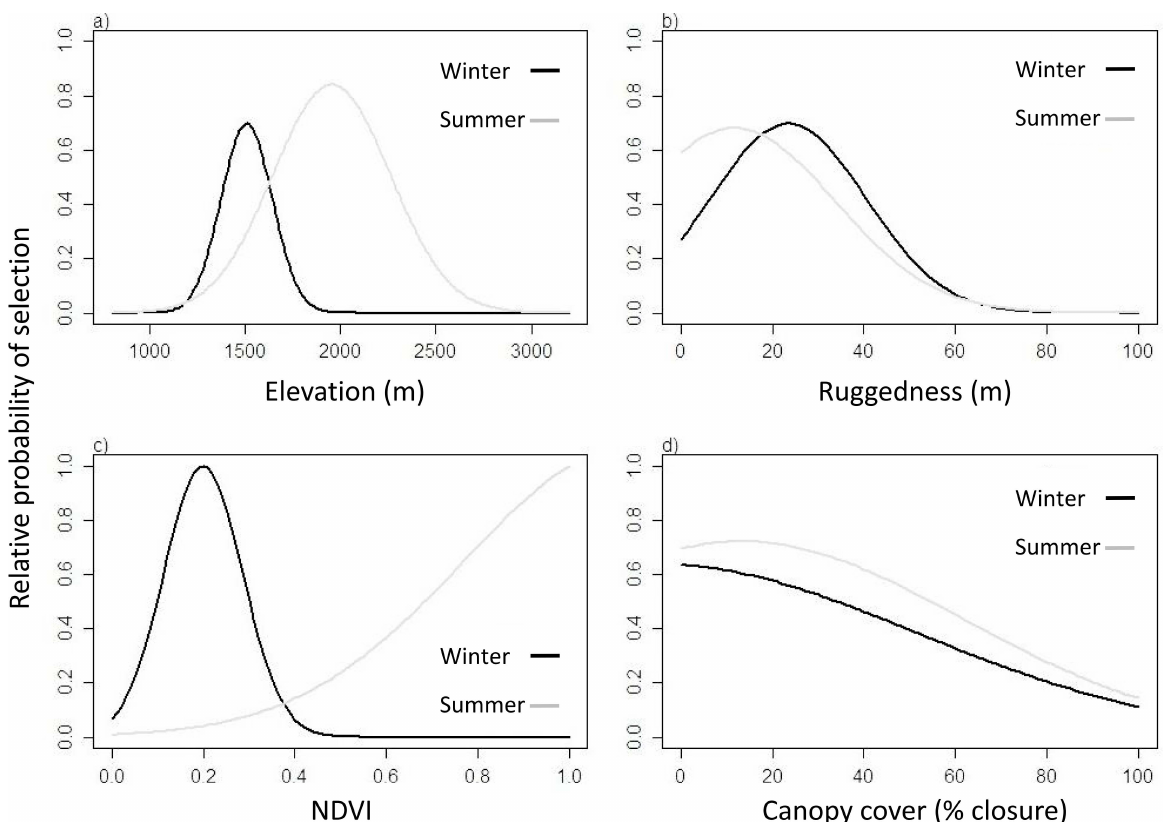
Fig 2. Relativeprobabilityof selection estimated by Resource Selection Functions (RSFs) in winter and summer for a) elevation, b) terrain ruggedness,c) normalizeddifferencevegetationindex NDVI and d) canopy cover.